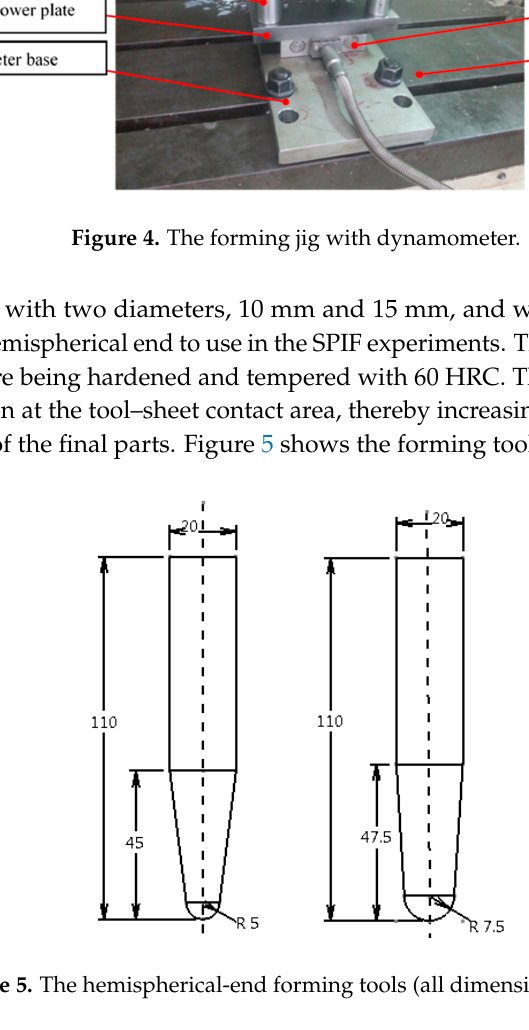
Table 1. Chemical composition (wt %) of the material.